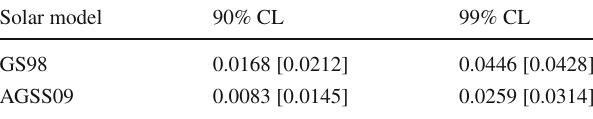
Table2 Upperlimitsonsin 2 θ 14 at90%and99%CLfromcurrentsolar neutrino data for the GS98 and AGSS09 solar models obtained with the MC simulation assuming a true value of sin 2 θ 12 = 0 . 313 (GS98) and 0 . 319 (AGSS09). The numbers in brackets would be the corresponding limits assuming a χ 2 -distribution with 1 dof for the test statistic Solar